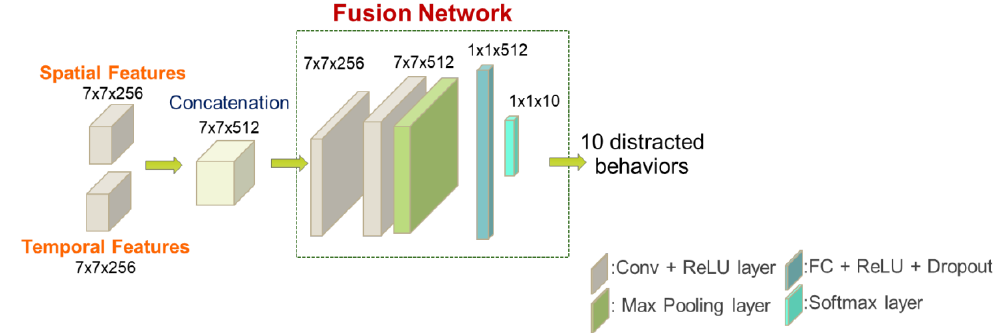
Figure 4. Configuration of fusion network.